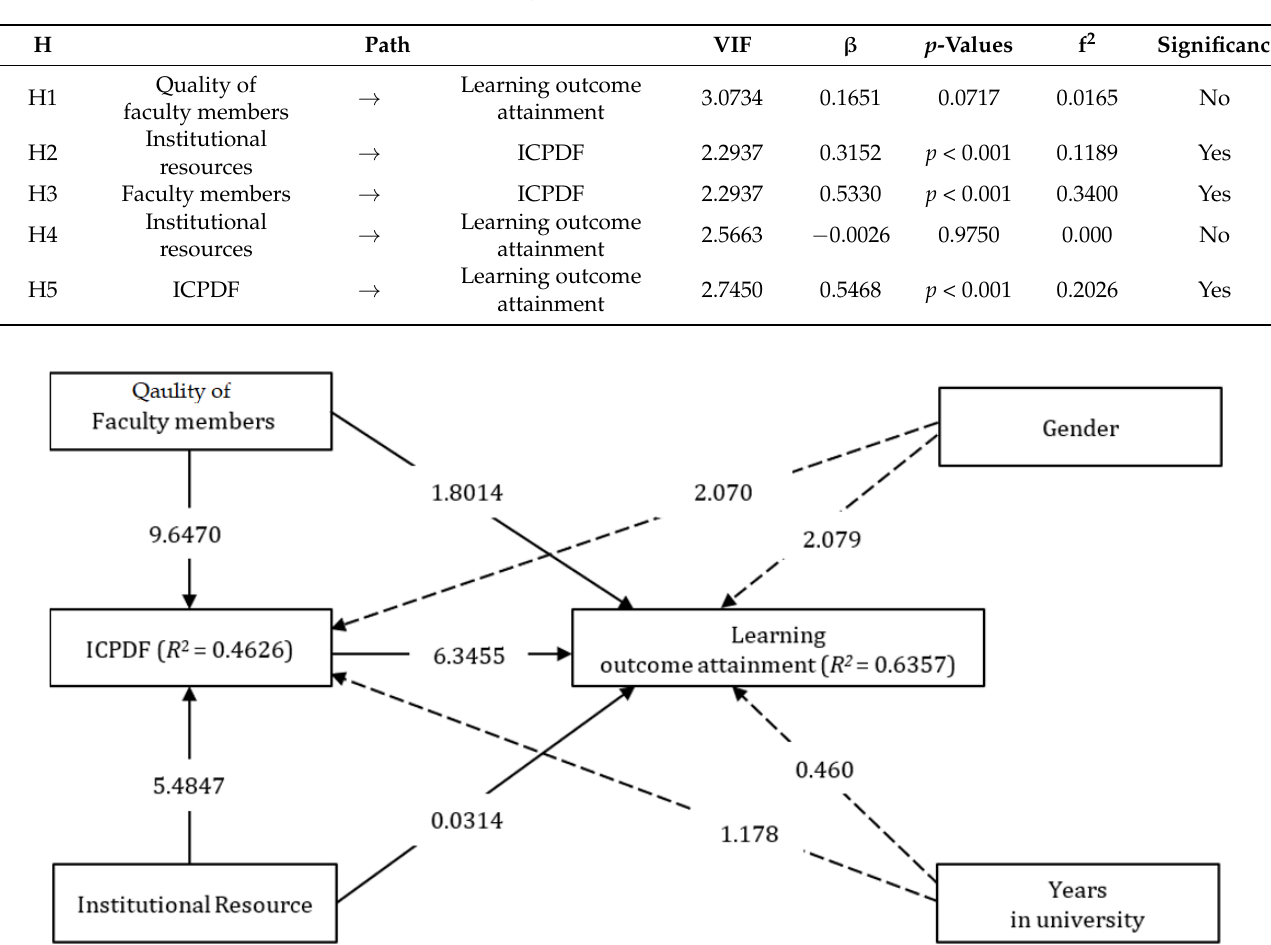
Table 5. VIF, β , t-, and p -values.